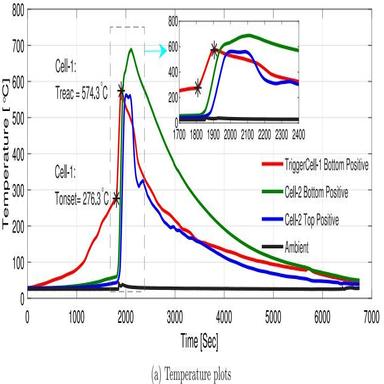
Overheating test of battery module without any thermal barriers (a) Test setup (b) Temperature plot.